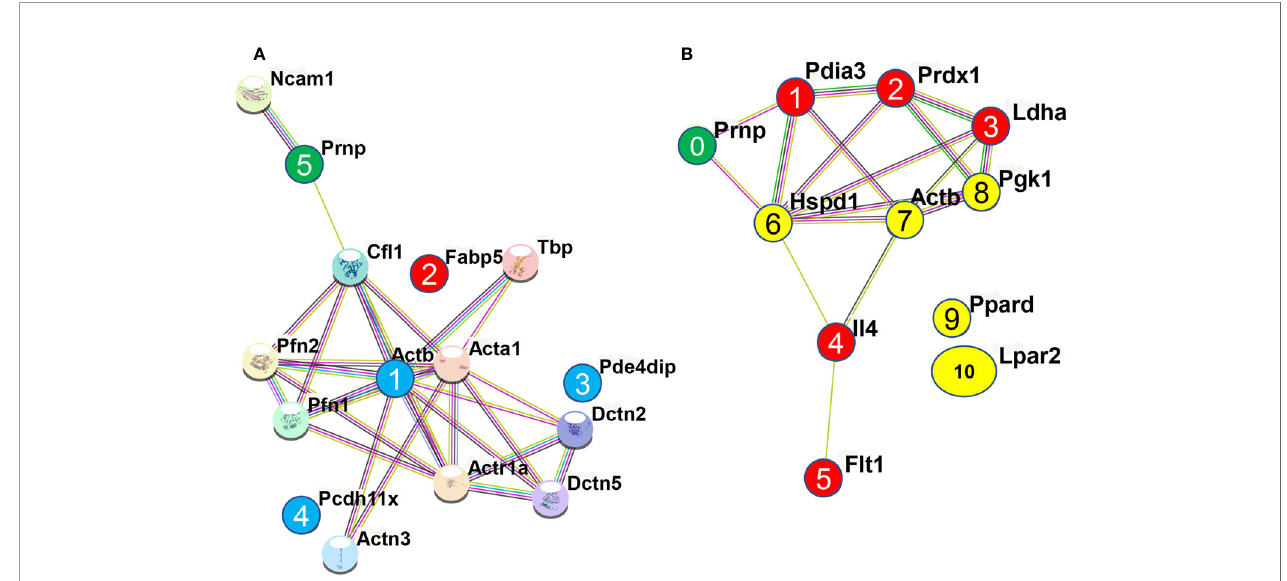
FIGURE 3 | Protein-protein interaction of the identi fi ed allergenic genes following direct antibody treatment (DAT) of mouse neuroblastoma cells and mouse primary neuron (MPN). Protein-protein interaction analysis was performed using STRING v11.0 server. The Mus Musculus database was used as the host organism for the identi fi cation of protein interactions. (A) Protein-protein interaction of the identi fi ed allergenic genes in mouse neuroblastoma cells. Herein, interaction among the allergenic proteins (numbered 1, 2, 3, & 4) and with PrP C (numbered 5) following direct antibody treatment. (B) Protein-protein interaction of the identi fi ed allergenic genes in mouse primary neuron (MPN). Herein, interaction among the allergenic proteins (numbered 1, 2, 3, 4, 5, 6, 7, 8, 9 & 10) and with PrP C (numbered 0) following direct antibody treatment, where red and yellow color indicate the downregulated and upregulated genes, respectively and green color represents the cellular prion protein PrP C